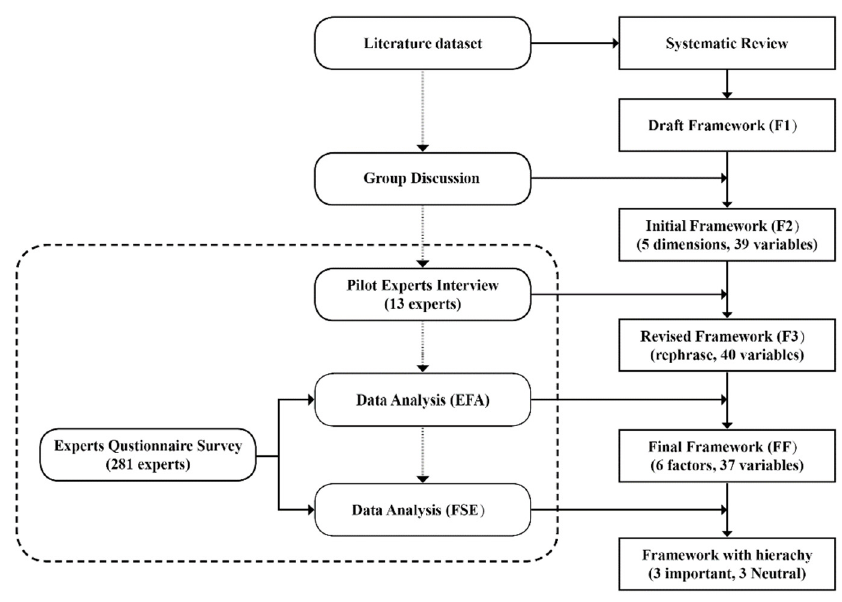
Figure 1. Research